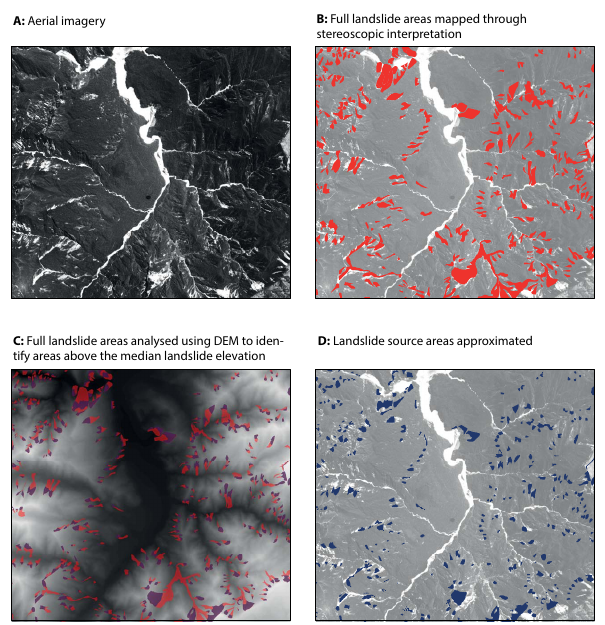
Figure B1. Illustration of landslide source area extraction tech- nique for a 10 × 10km sample area, showing landslides triggered by the 1929 Buller earthquake.